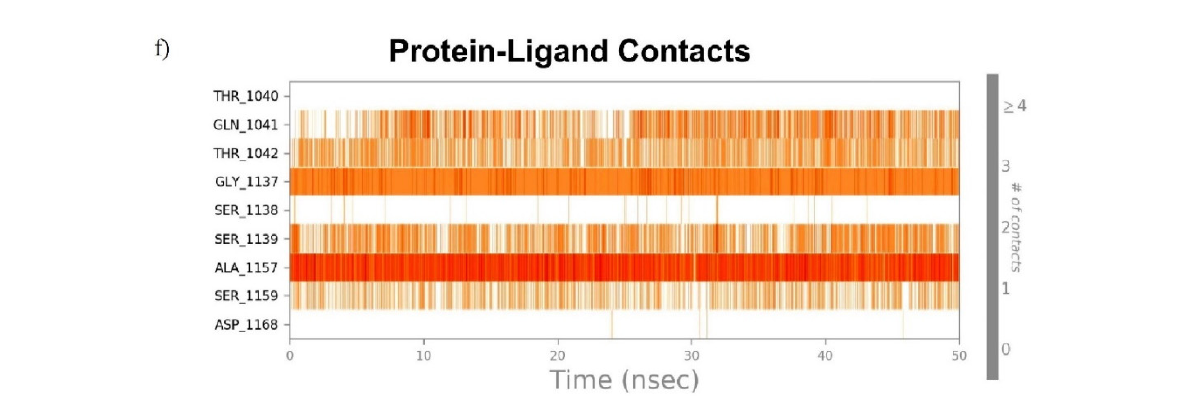
Figure 9. MD trajectories of Asunaprevir in complex with HCV NS3/4A for a 50 ns simulation: ( a ) RMSD, ( b ) RMSF, ( c ) rGyr, and ( d – f ) residue-wise ligand–protein contacts.